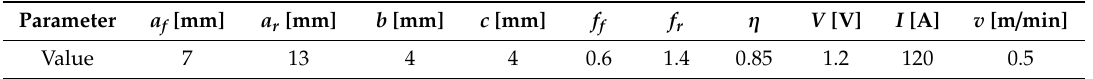
Table 3. Heat source parameters for the